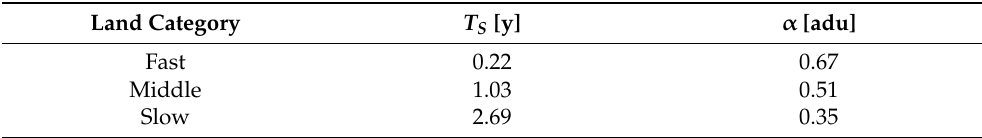
Table 2. The values of environmental half-life ( Ts ) and fraction ( α ) of the short-term decay component; they were adopted from the 5th percentile, median and 95th percentile values derived from the observations of ambient dose in Fukushima Prefecture